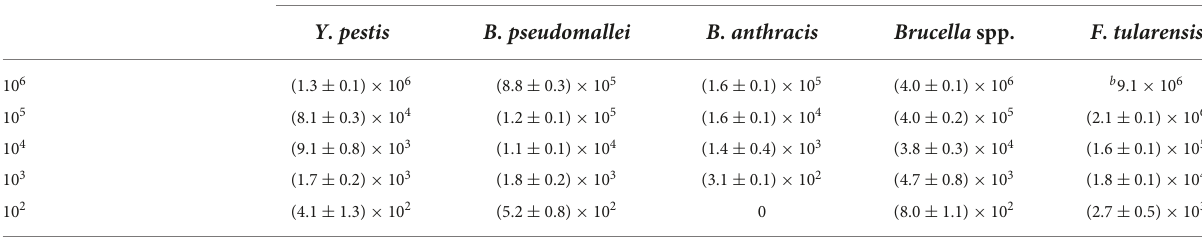
TABLE 3 Estimated bacterial amount of the five selected agents in soil samples (CFU/100 mg soil) by ddPCR. Amount by plate count